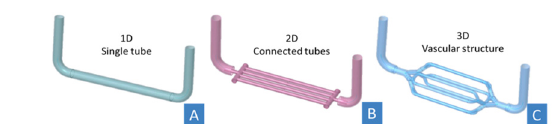
Figure 10 . Vascular network systems for self ‐ healing of concrete developed by Li et al. [38] (CC BY